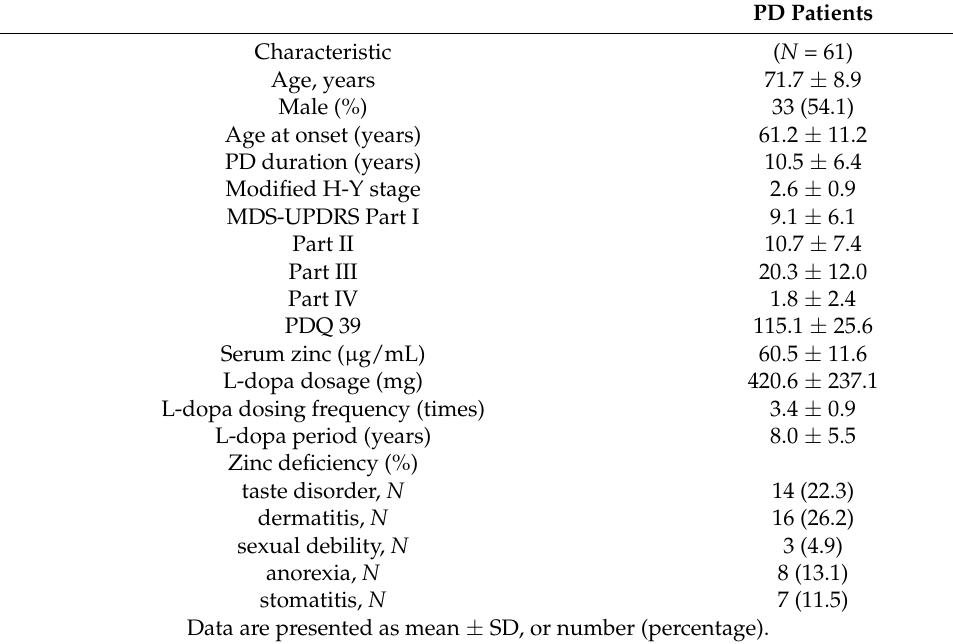
Table 1. PD patient demographicsand clinical